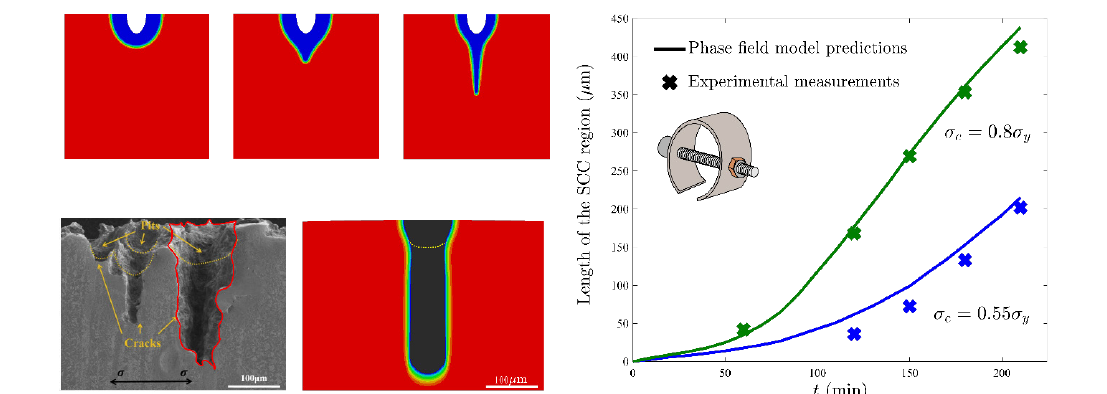
Figure 4. Phase field modelling of the processes of pitting, pit-to-crack transition and SCC, including experimental validation. The results reported belong to Ref. [15]. The governing equations for the phase field and